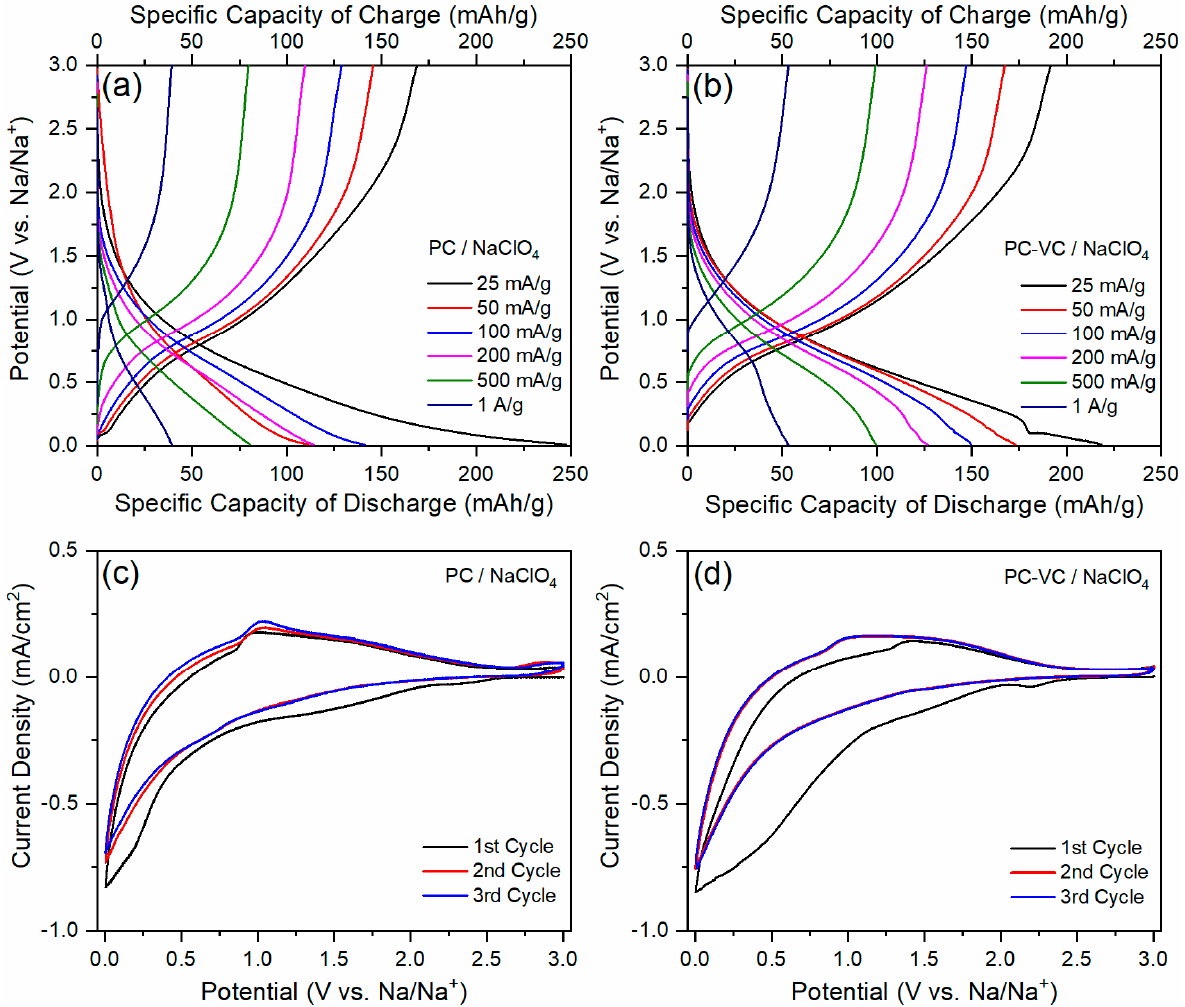
Figure 3. Galvanostatic voltage profiles of TiO 2 nanosheet anodes in Na-ion half-cells containing: ( a ) PC / NaClO 4 , and ( b ) PC-VC / NaClO 4 electrolyte solutions at various current densities. Cyclic voltammograms of TiO 2 nanosheet anodes at a scan rate of 1 mV/s in ( c ) PC / NaClO 4 , and ( d ) PC-VC / NaClO 4 electrolyte solution.